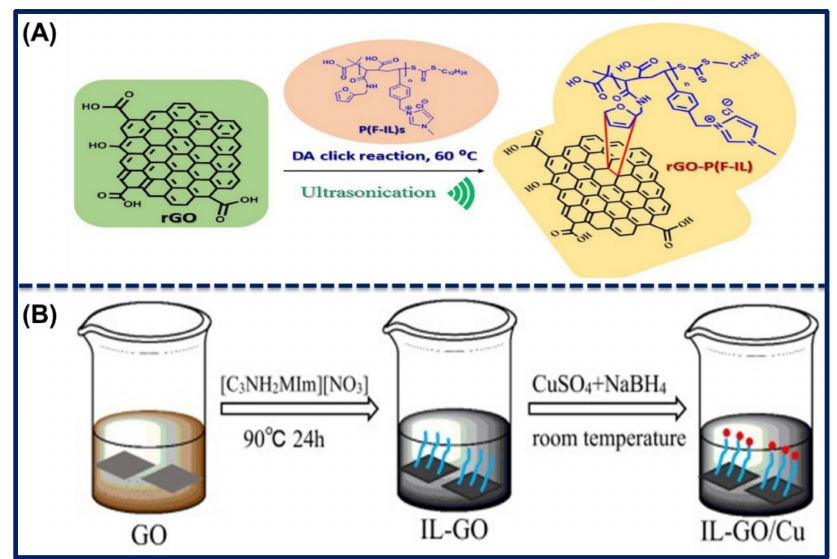
Figure 5. ( A ) Synthetic scheme for the preparation of RGO-Poly(F-IL) hybrids. Reprinted with permission from Ref. [70]. Copyright 2020, Elsevier; and ( B ) GO-ILs/CuNPs composite. Reprinted with permission from Ref. [71]. Copyright 2019,